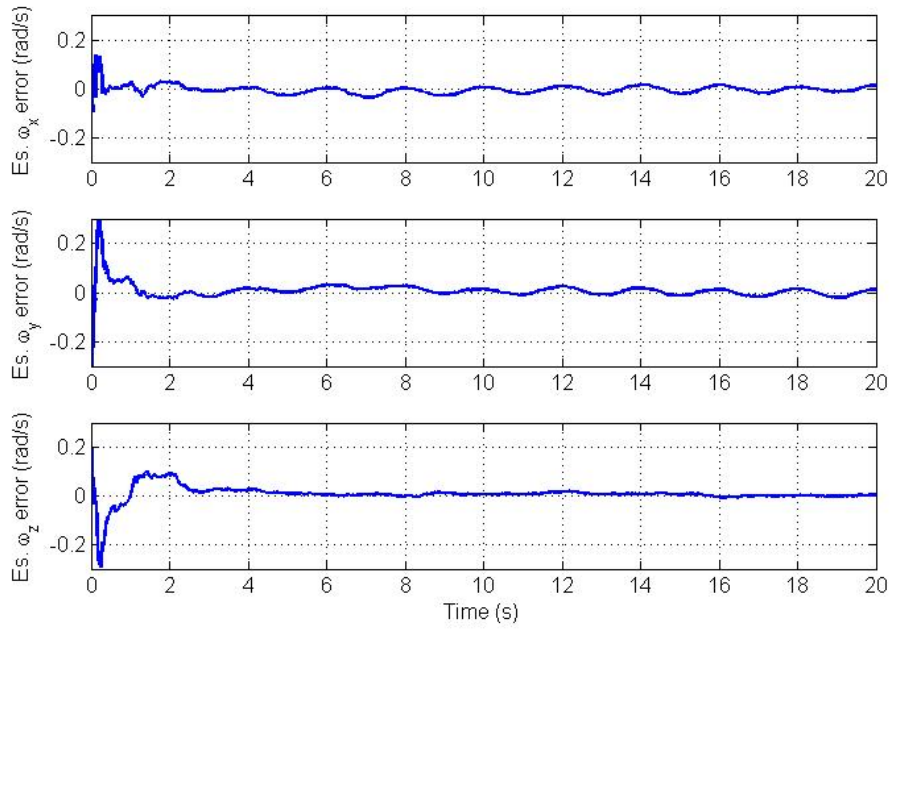
Figure 7. Angular velocity vector estimation errors for improper